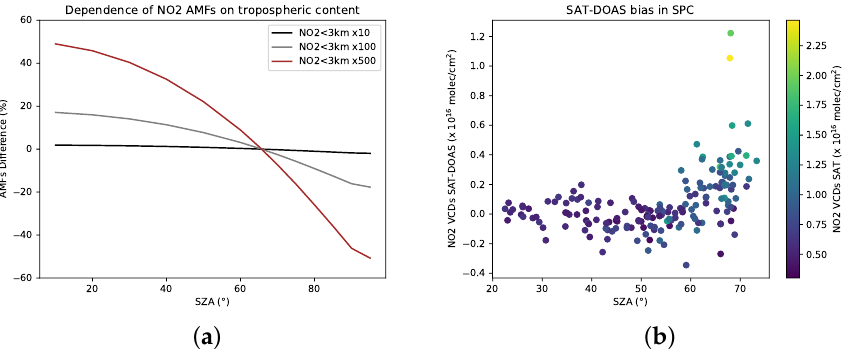
Figure 12. ( a ) Percentage differences between NO 2 AMFs computed with increased NO 2 tropospheric content and non-perturbed profile. ( b ) Differences between NO 2 VCDs measured by TROPOMI and SkySpec-2D in SPC with respect to the SZA and the NO 2 VCDs measured by